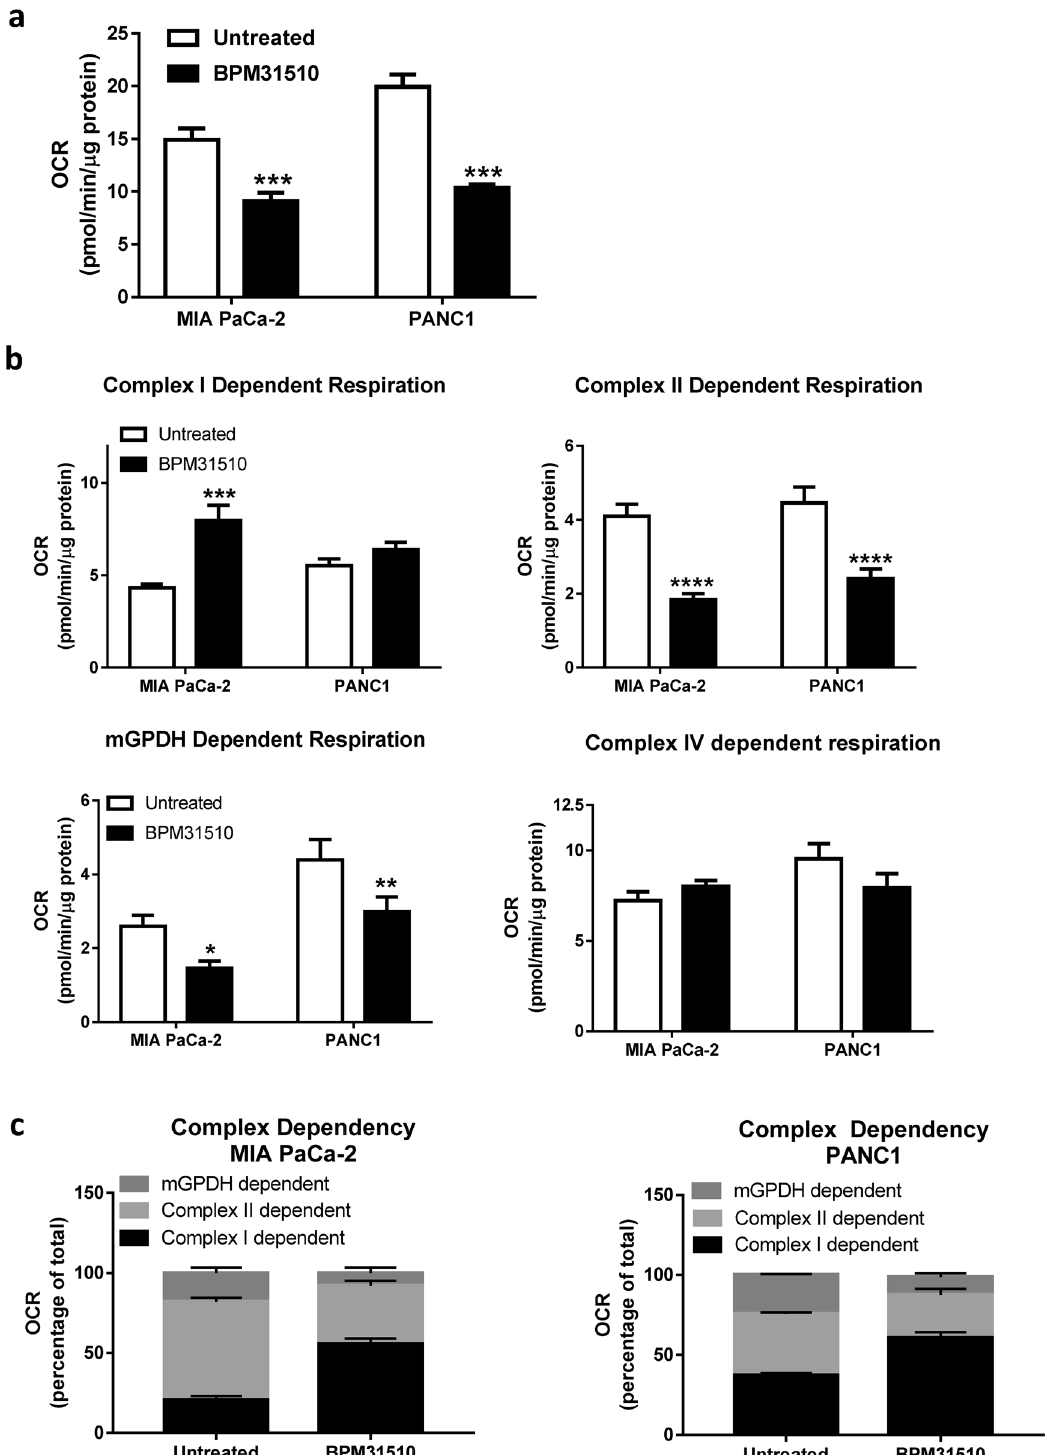
Figure 2. BPM31510 decreases Q-pool linked Complex II and mitochondrial glycerol-3-phosphate dependent respiration, resulting in shifts in respiratory dependency of specific mitochondrial complexes. ( a ) State 3 respiration on pyruvate/malate + succinate + glycerol-3-phosphate in MIA PaCa-2 and PANC1 cells after BPM31510 treatment. ( b ) Effects of BPM31510 on electron transport chain complex (substrate-specific) respiration in MIA PaCa-2 and PANC1 cells. The data represent the means + SEM of three independent experiments. ( c ) BPM31510 shifts respiratory dependency in MIA PaCa-2 and PANC1 cells. Complex-specific respiration was assessed as described in the Methods section. The data report the percentage of total respiration. The data represent the means + SEM of three independent experiments. The data were analysed by Student’s t-tests; *** p < 0.001 compared to untreated